Question: Looking at the figure, what chart type is it?
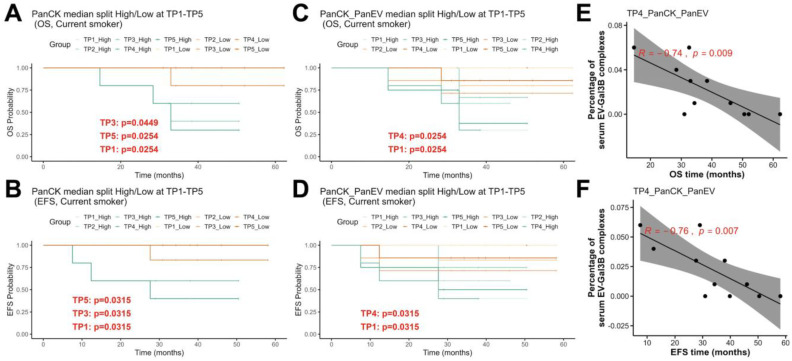
Answer: survival